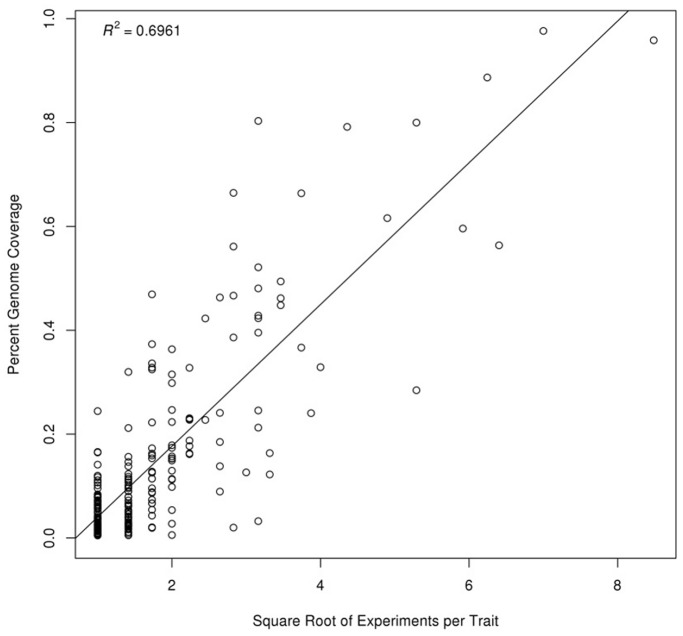
Number of QTLs per Trait vs Genome Coverage.The scatterplot shows the relationship between the total percent covered of the physical genome versus the square root of the number of experiments per trait for QTL data from Gramene. Inset shows plot of residuals.